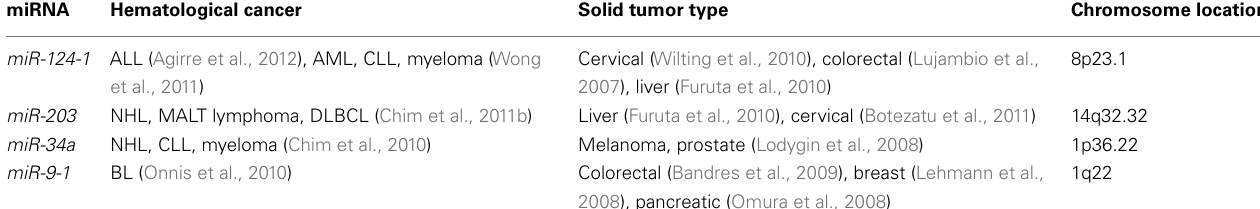
Table 2 | Methylated tumor suppressive miRNA common in both lymphoma and other hemic cancers/solid tumors. miRNA Hematological cancer